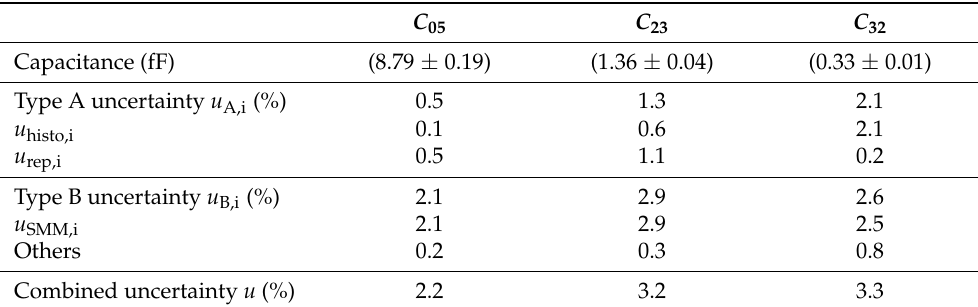
Figure 4. Relative differences Δ C i / C calc,i between measured C m,i and calculated C calc,i capacitance values for 48 capacitors C i of the following patterns: ( a ) A61F08, ( b ) A61E07, ( c ) A45E08, and ( d ) A64F07. Table 5. Relative uncertainties for 3 typical capacitance values (high, intermediate, low) of the pattern A61F08.